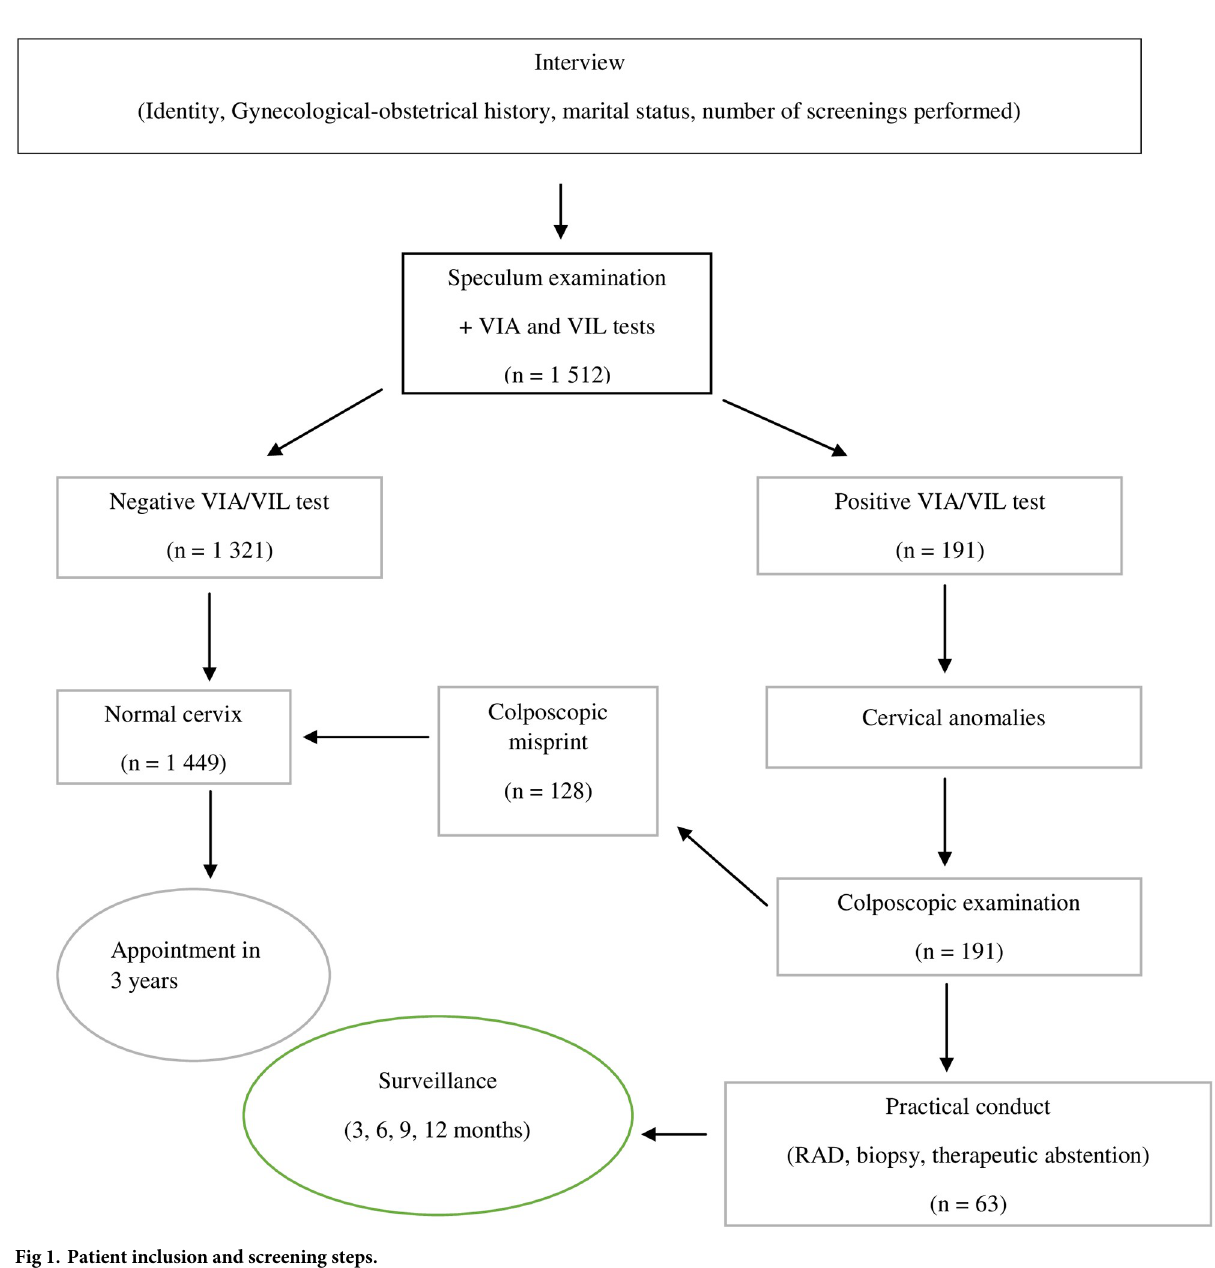
Fig 1. Patient inclusion and screening